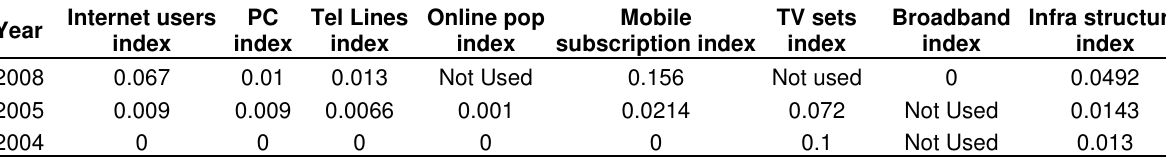
Table 3. Nigeria infrastructure index.